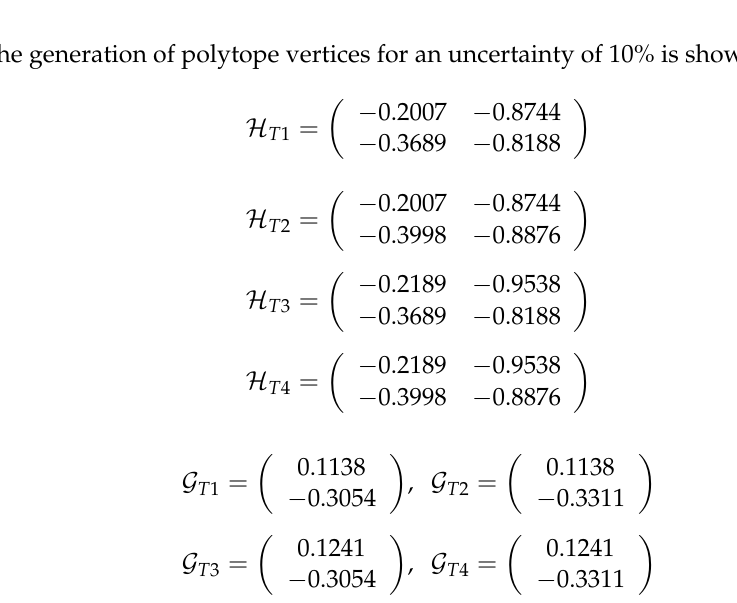
Table 3. Robustness analysis showing different ranges of C Y